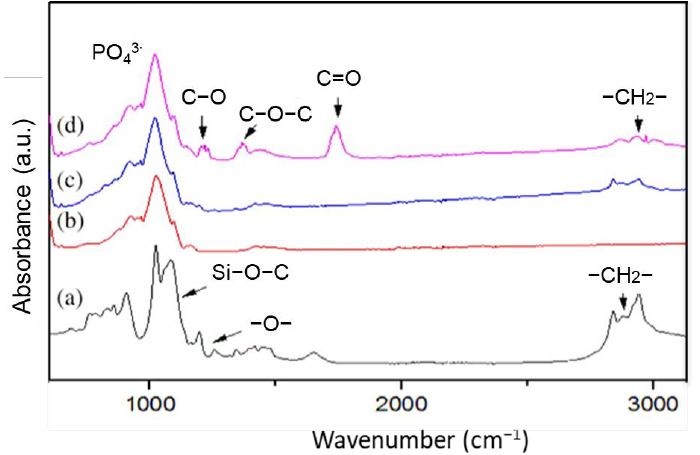
Figure 7. FT-IR spectra of ( a ) GLYMO, ( b ) the ceramic support made of natural phosphate, ( c ) the modified ceramic support grafted using silane, and ( d ) the GO/ceramic membrane.